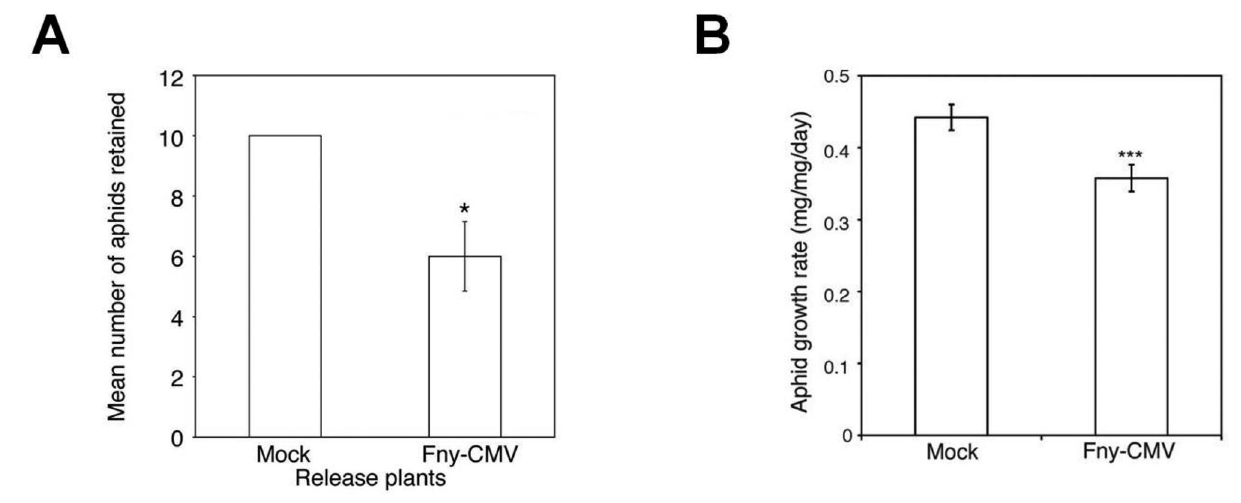
Figure 1. Aphid behavior and performance on virus-infected wild-type Arabidopsis plants. (A) Ten aphids ( Myzus persicae ) were released onto rosettes of mock-inoculated or Fny-CMV-infected release plants and then allowed to remain or emigrate to a plant of the opposite treatment group located 10 cm away in the same pot. Aphids migrated away more often from Fny-CMV- infected than from mock-inoculated plants. Fewer aphids remained on Fny-CMV-infected than on mock-inoculated release plants after 24 hours. Based on the methods of Mauck et al. [8], three independent tests were performed for each type of release plant. See Figure S1 for the accompanying aphid choice data. (B) Mean relative growth rate of individual aphids feeding on Arabidopsis plants infected with Fny-CMV, n≥24. Error bars represent standard error of the mean. Asterisks indicate significant differences (Student’s t -test): *, P <0.05; **, P <0.01; ***, P <0.001.